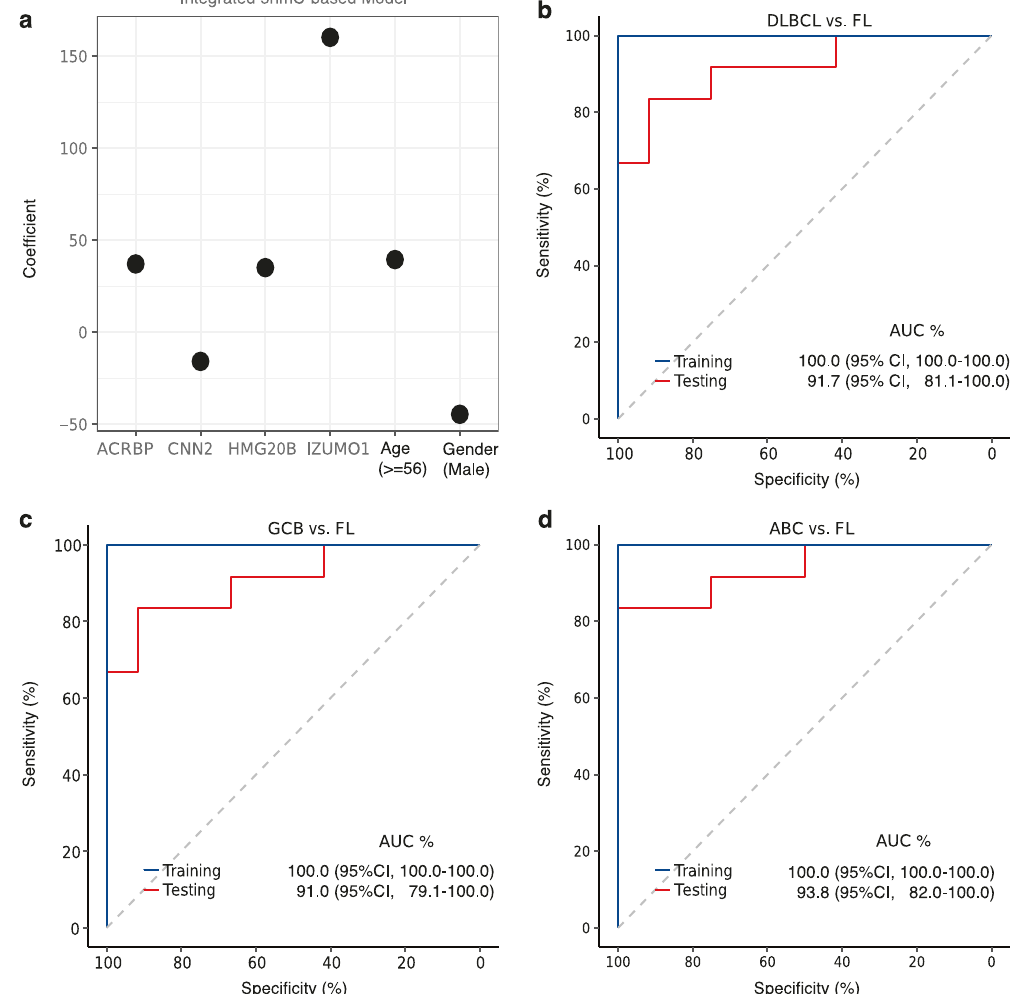
Fig. 2 An integrated 5hmC-based model summarizes differential epigenetics in cfDNA between DLBCL and FL. a The covariates and coef fi cients of the integrated model are shown. The performance of the integrated 5hmC-based model is shown for distinguishing: b DLBCL vs. FL; c GCB-type DLBCL vs. FL; and d ABC-type DLBCL vs. FL. DLBCL diffuse large B-cell lymphoma, FL follicular lymphoma, GCB germinal center B-cell-like DLBCL, ABC activated B-cell-like DLBCL, AUC area under curve, CI con fi dence